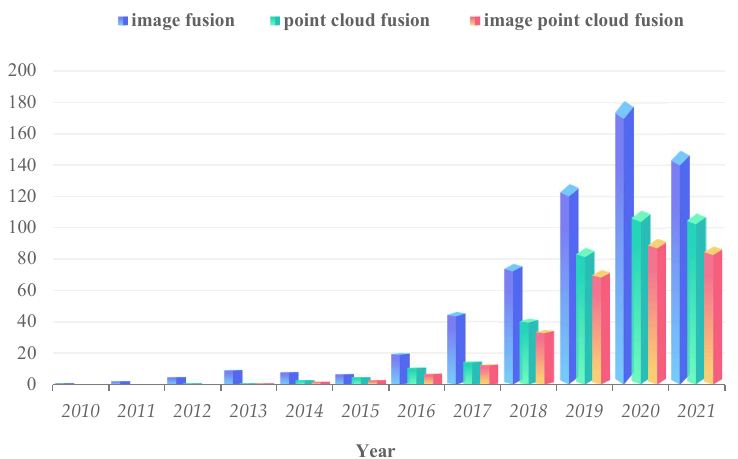
Figure 2. The increasing amount of research on cooperative perception multi-sensor information fusion in the Internet of vehicles environment.